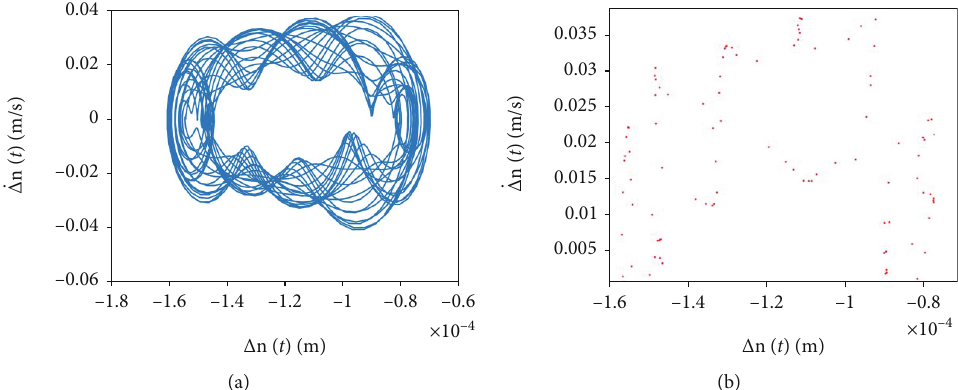
Figure 20: When the wear is 5 : 565 × 10 ‐ 5 m (the misalignment in the x direction is 2 : 8 × 10 − 4 m): (a) relative displacement velocity and (b) the corresponding diagram of Poincare.